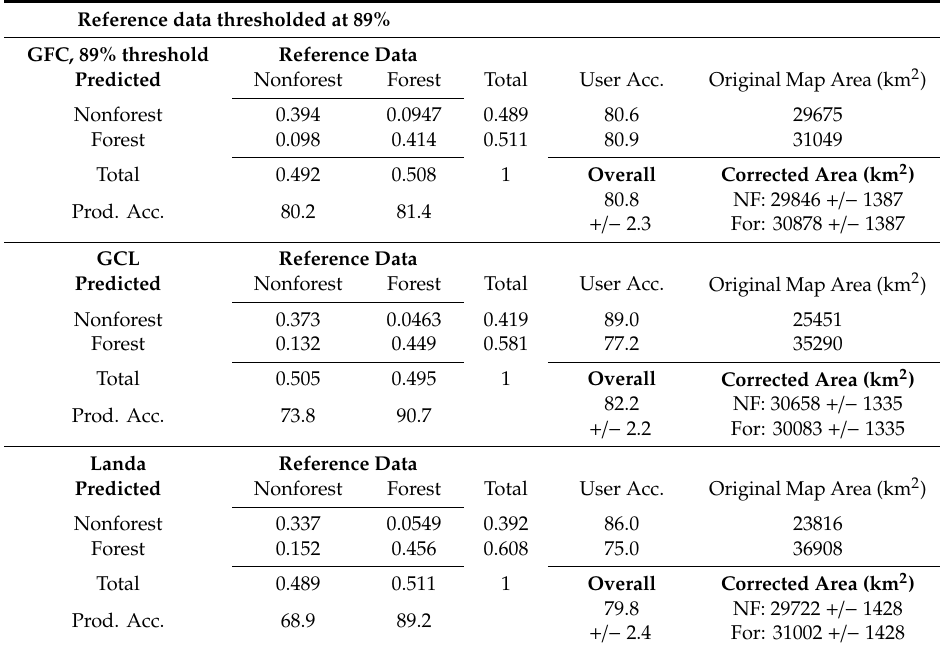
Table A2. Detailed, area-corrected confusion matrices showing the user’s, producer’s, and overall accuracy of di ff erent forest / non-forest maps at the 89% forest cover threshold. Overall accuracy and corrected area estimates are shown (mean +/ − 95% confidence